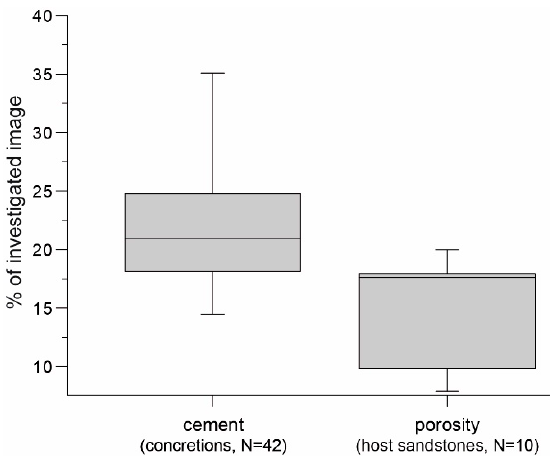
Figure 13. Box-plots of percentages of calcite cements in concretions (left) and preserved porosity in host sandstones (right) estimated from image analysis of cathodoluminescence photomicrographs (concretions) and optical microscopy and SEM photomicrographs (host sandstones).